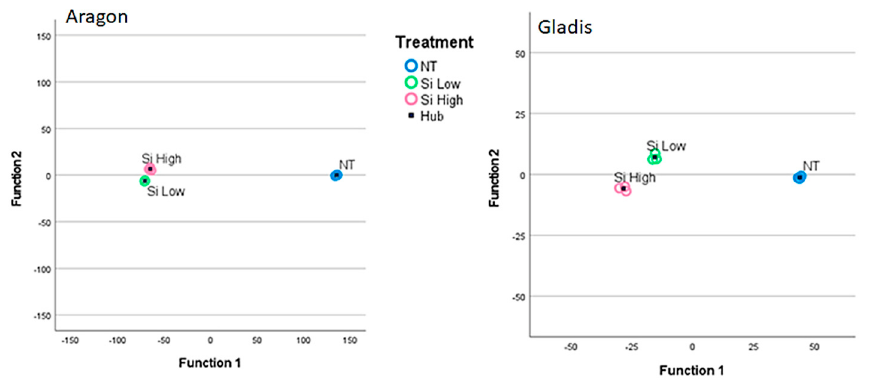
Figure 1. Discriminant canonical functions analysis for the physiological analyses according to treatments (Control, Si Low, Si High) and grouped by parts of the plant: blue = leaf, green = root, pink = fruit. Blue square = hub of the group. Left side Aragon, right side